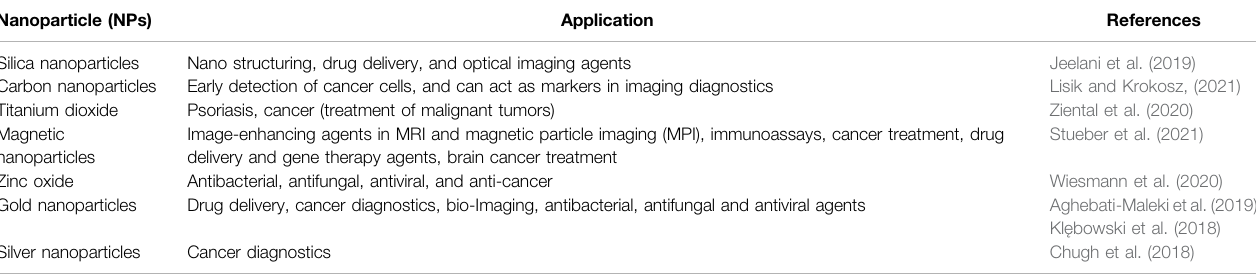
TABLE 2 | Application of NPs in